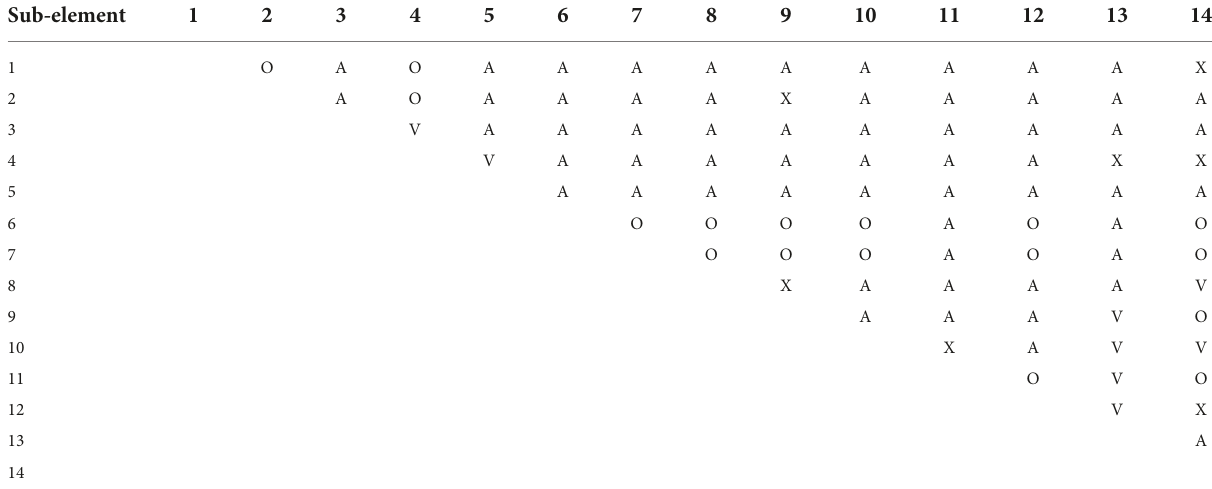
TABLE 3 Matrix structural self-interaction matrix (SSIM).